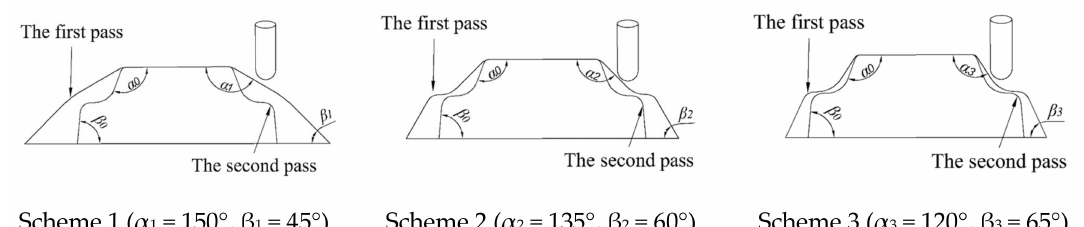
Figure 8. Schematic of the forming trajectory and motion direction.